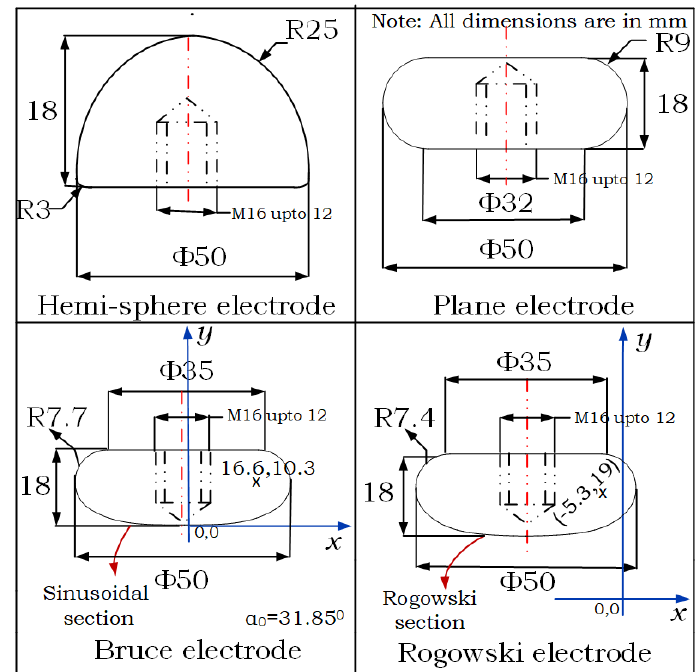
Figure 3. Physical dimensions of fabricated electrodes.